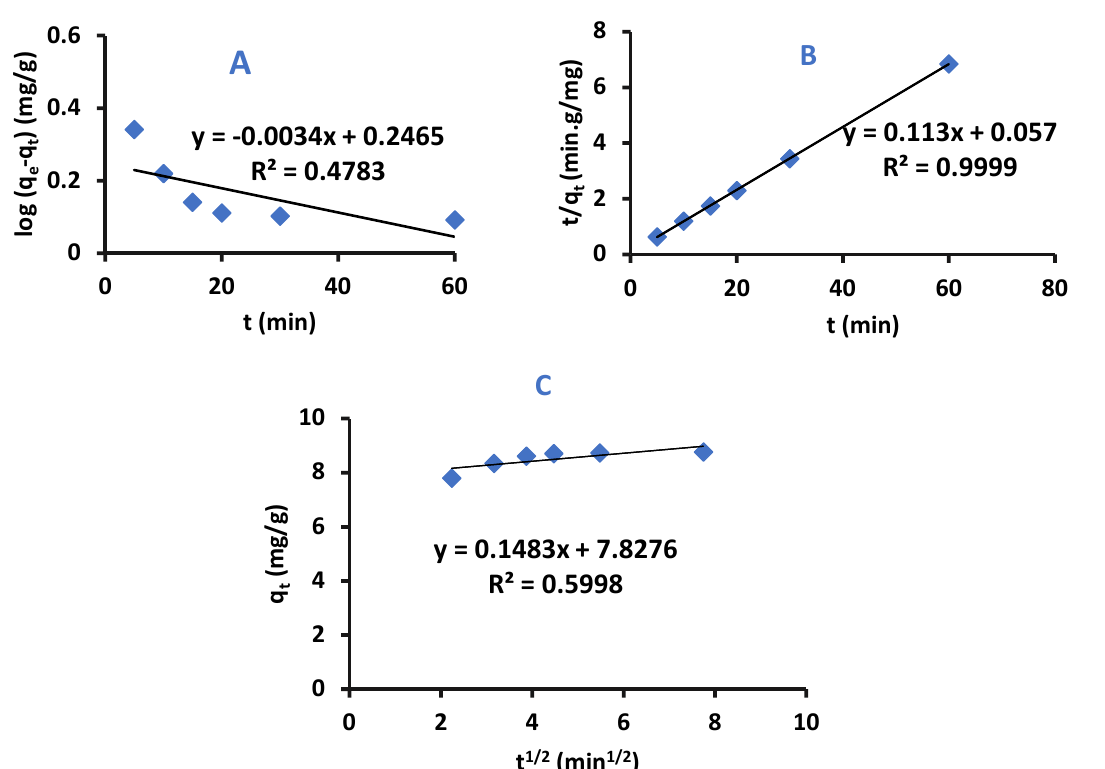
Figure 11. Pseudo-first-order ( A ), Pseudo-second-order ( B ), and Intra-particle-diffusion kinetic ( C ) of difenoconazole removal by Cell-D (C I : 10 ppm, volume: 10 mL, temperature: 20 °C, pH: 7, dose: 10 mg).